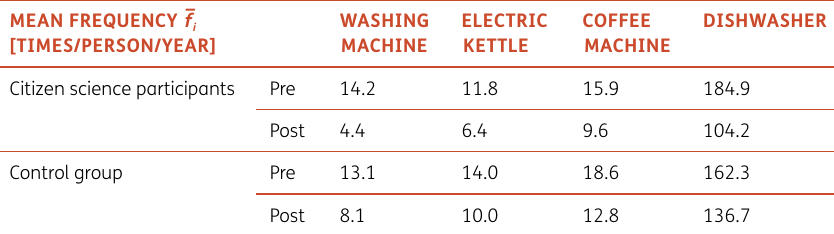
Table 6 Average frequency of use of calcium-removal